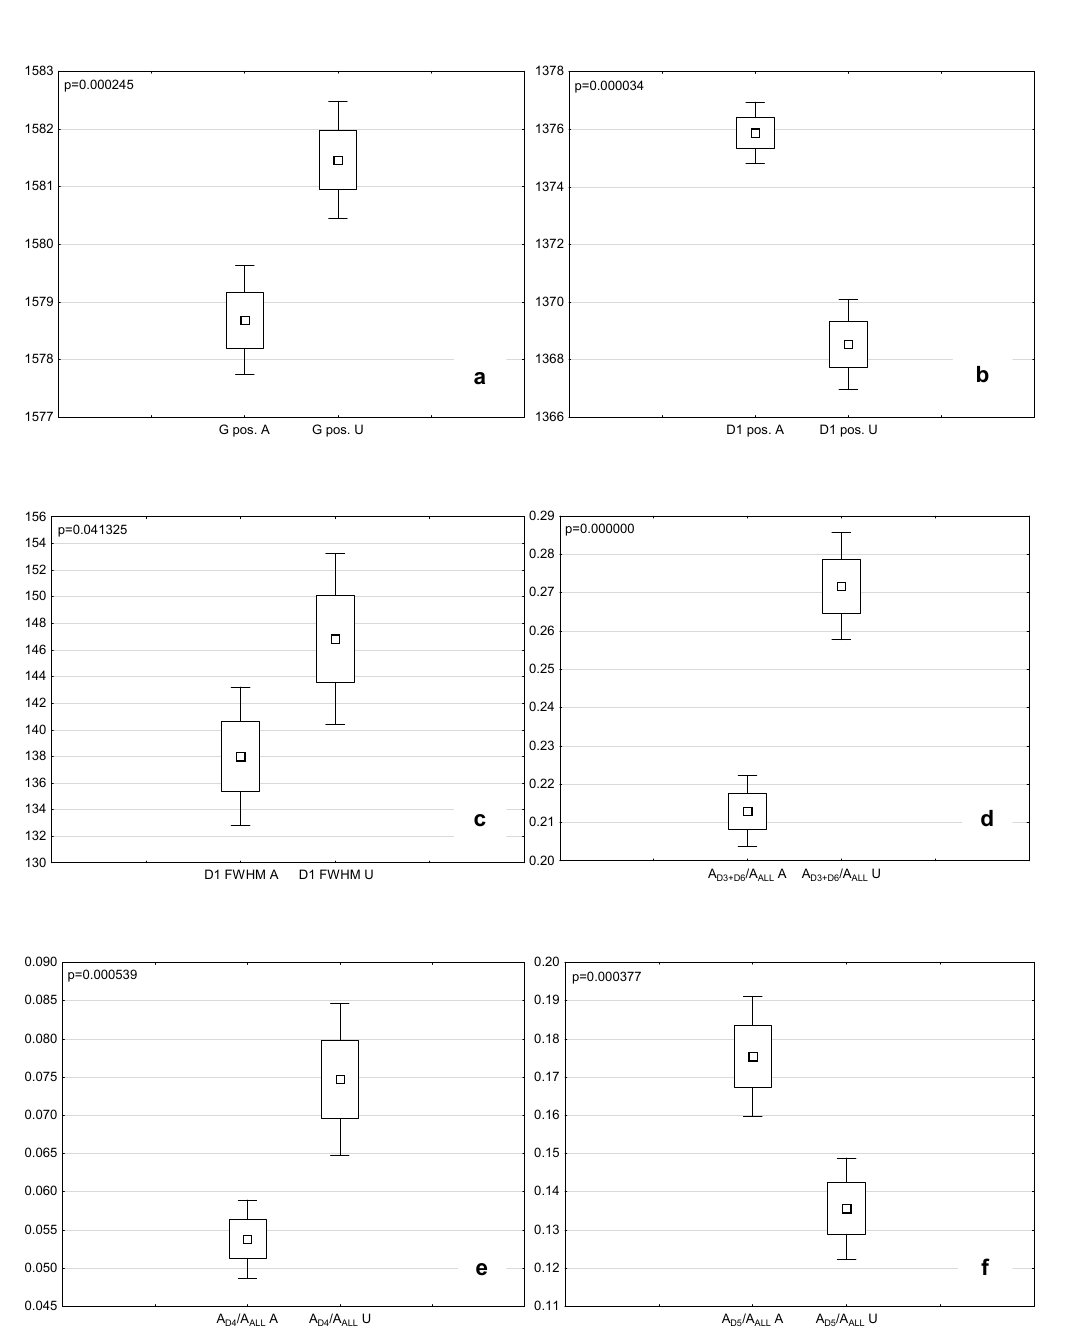
Figure 5. Comparison of Raman spectral parameters obtained for attrinite and ulminite: G band position ( a ), the D1 band position ( b ), the D1 band FWHM ( c ), the A D3+D6 /A ALL ratio ( d ), A D4 /A ALL ratio ( e ) and the A D5 /A ALL ratio ( f ). Explanation: